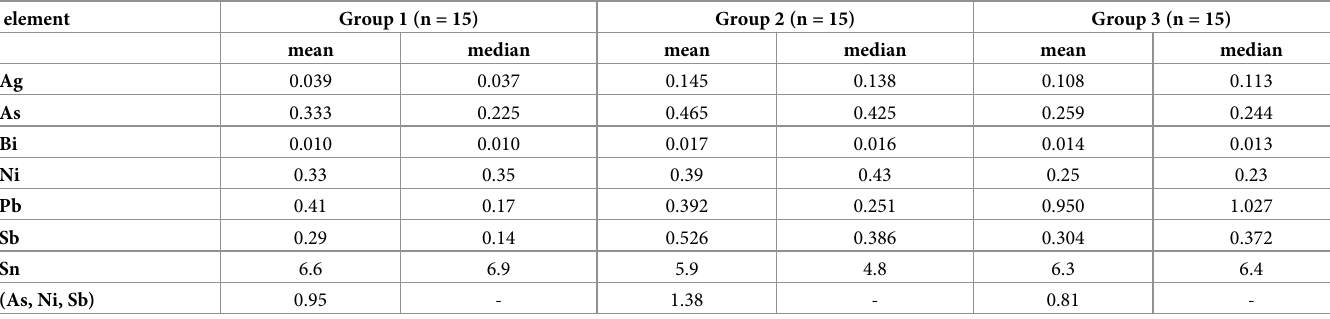
Table 2. Mean and median values for various element concentrations of the artefacts under study.